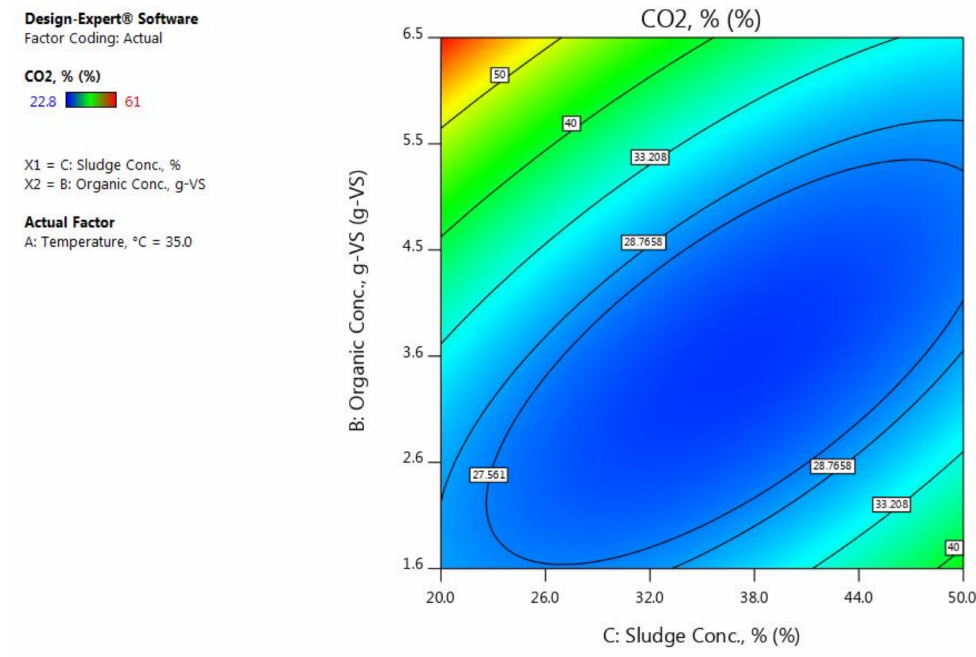
Figure 10. A contour plot illustrating the influence of (BC) on the CO 2